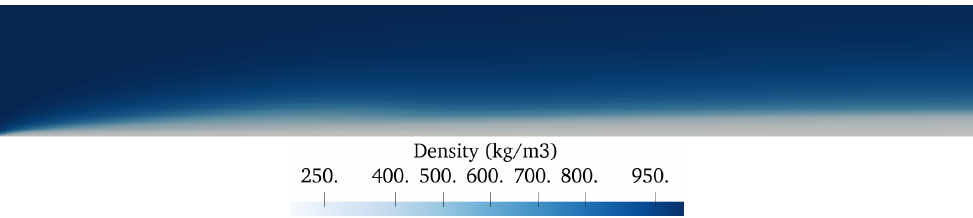
Figure 7. Density contour plots at 12 MPa for wall temperature T w = 390 K. The figure shows the density distribution for a dense/cool flow coming from the left, and passing over a heated plate at the bottom. At the heated wall, a low-density vapor-like layer